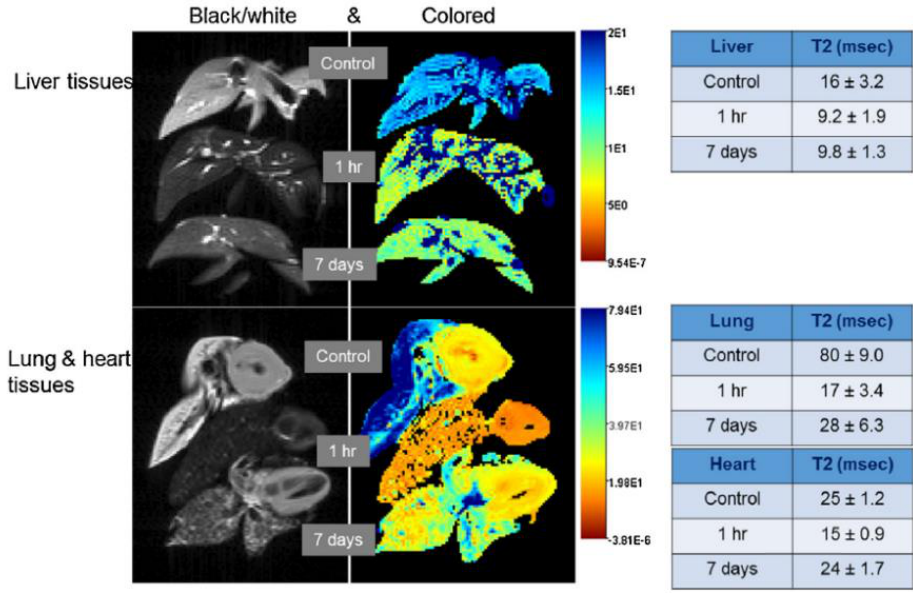
Figure 9. Magnetic resonance imaging of swiss mice model liver, lung and heart tissues after magnetogel injection via tail vein to monitor the in vivo biodistribution, the animals having been sacrificed at 1 h and 7 days after injection. Adapted from [38] with permission from Elsevier, 2015.